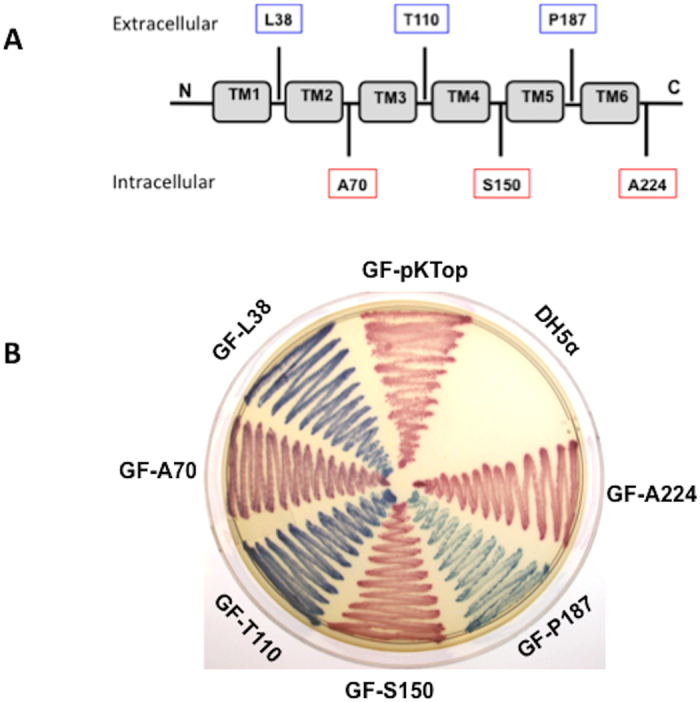
Experimental determination of the ComD membrane topology.(A) A schematic diagram indicates the reporter fusion points at L38 (pKTop-ComD1-L38), A70 (pKTop-ComD1–A70), T110 (pKTop-ComD1–T110), S150 (pKTop-ComD1–S150), P187 (pKTop-comD1–P187) and A224 (pKTop-ComD1–A225) of the ComD membrane-spanning region. Blue boxes indicate extracellular locations, while pink boxes indicate cytosolic locations as predicted by the hypothetical model. (B) The strains expressing the ComDL38-Pho/Lac (GF-L38), ComDT110-Pho/Lac (GF-T110) and ComDP187-Pho/Lac (GF-P187) exhibit the higher levels of phosphatase activity (blue color), indicating the extracellular location of the reporter fusion points. The strains expressing the ComDA70-Pho/Lac (GF-A70), ComDS150-Pho/Lac (GF-S150) and ComDA225-Pho/Lac (GF-A224) exhibit the higher levels of β-galactosidase activity (pink color), indicating the cytosolic location of the reporter fusion points. E. coli DH5α without pKTop (negative control) shows no color, while E. coli DH5α with pKTop or GF-pKTop (positive control) also shows pink color.